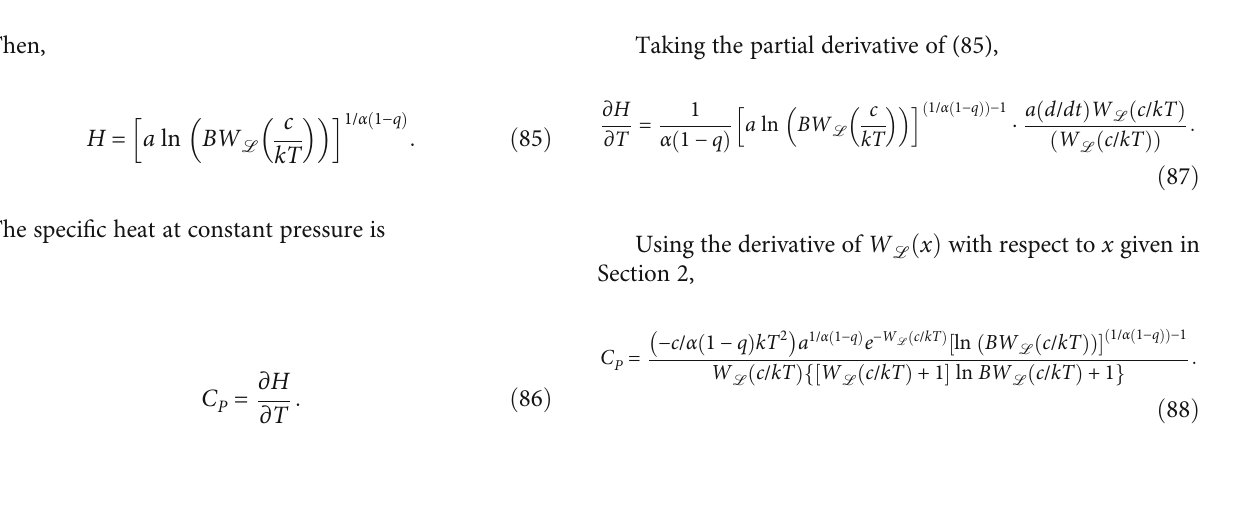
Figure 3: (a) Graph of C when q ′ , r vary and q = 0 : 4 , T = 2 , P = 3 , M = 2, D = 1 , and N = k = A = 1 . (b) Graph of C P = 0 : 2 , T = 3 , P = 4, M = 1 , D = 1, and N = k = A = 1